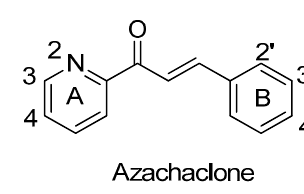
Figure 1. Structures of chalcones and azachalcones.